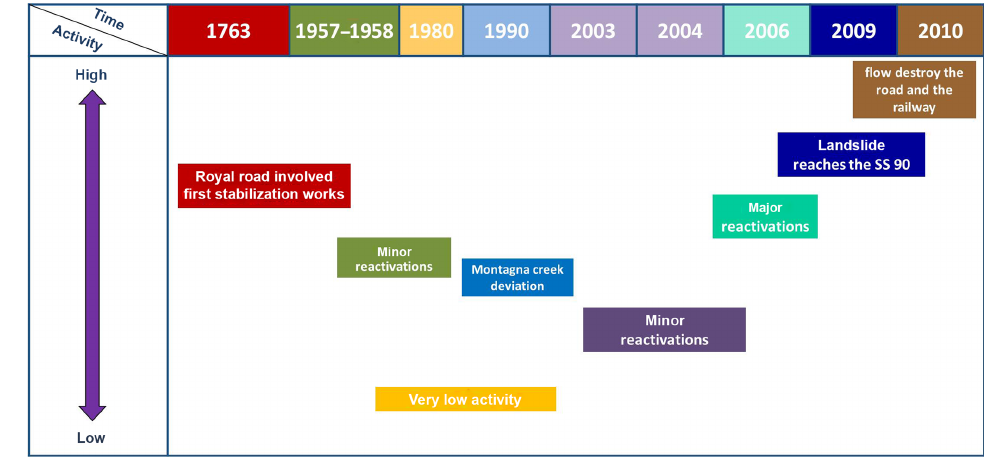
Figure 3. Timeline of the main landslide events recorded over the years.